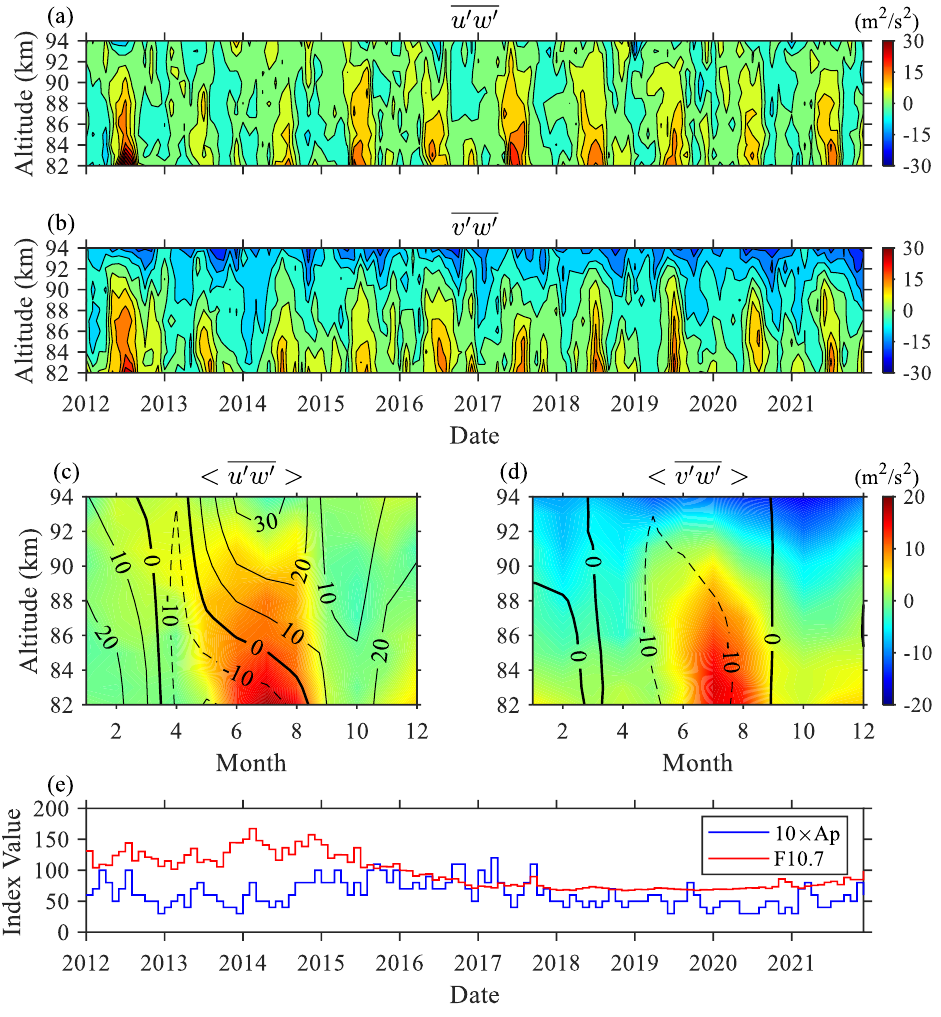
Figure 9. Estimated ( a ) zonal and ( b ) meridional GW momentum fluxes in different altitudes, for the period between 2012 and 2021. Contours ( c ) and ( d ) are the averaged results for the zonal and meridional GW momentum fluxes, respectively. Thin black solid (dash) lines indicate the decadal averaged monthly-mean winds with positive (negative) values. Thick black lines are zero winds. ( e ) Monthly variations of the geomagnetic (Ap, blue line) and solar flux (F10.7, red line) index.